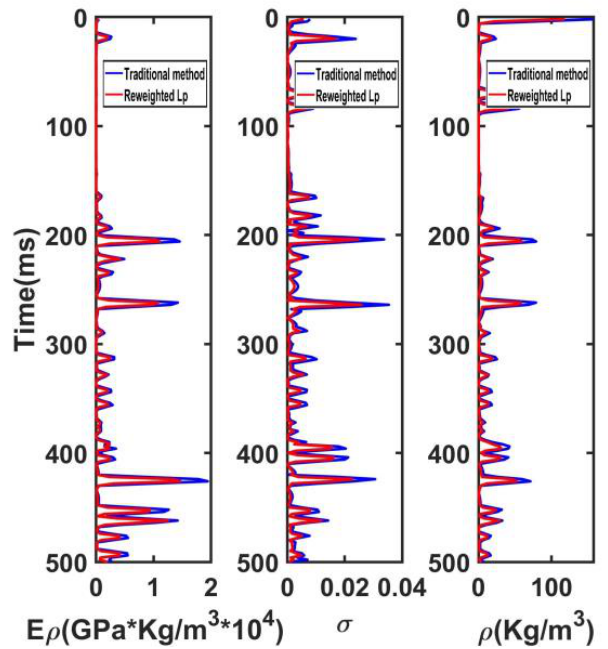
Figure 13. Absolute error comparison of the 500th inversion results.